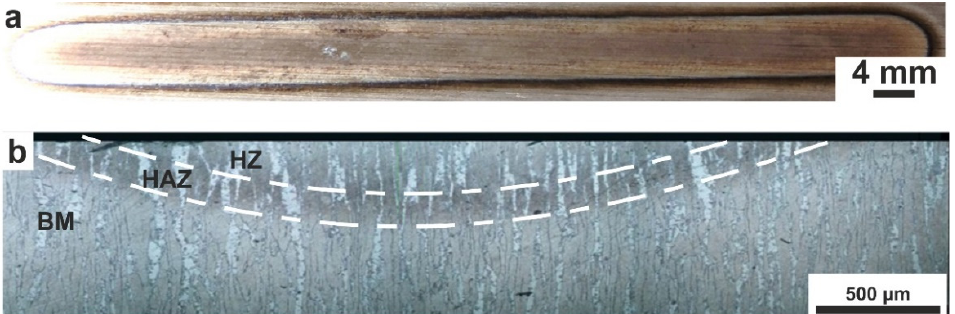
Figure 3. The microstructure of the hardened sample, mode No. 2: ( a ) the image of the hardened track; ( b ) the image of the microspecimen.